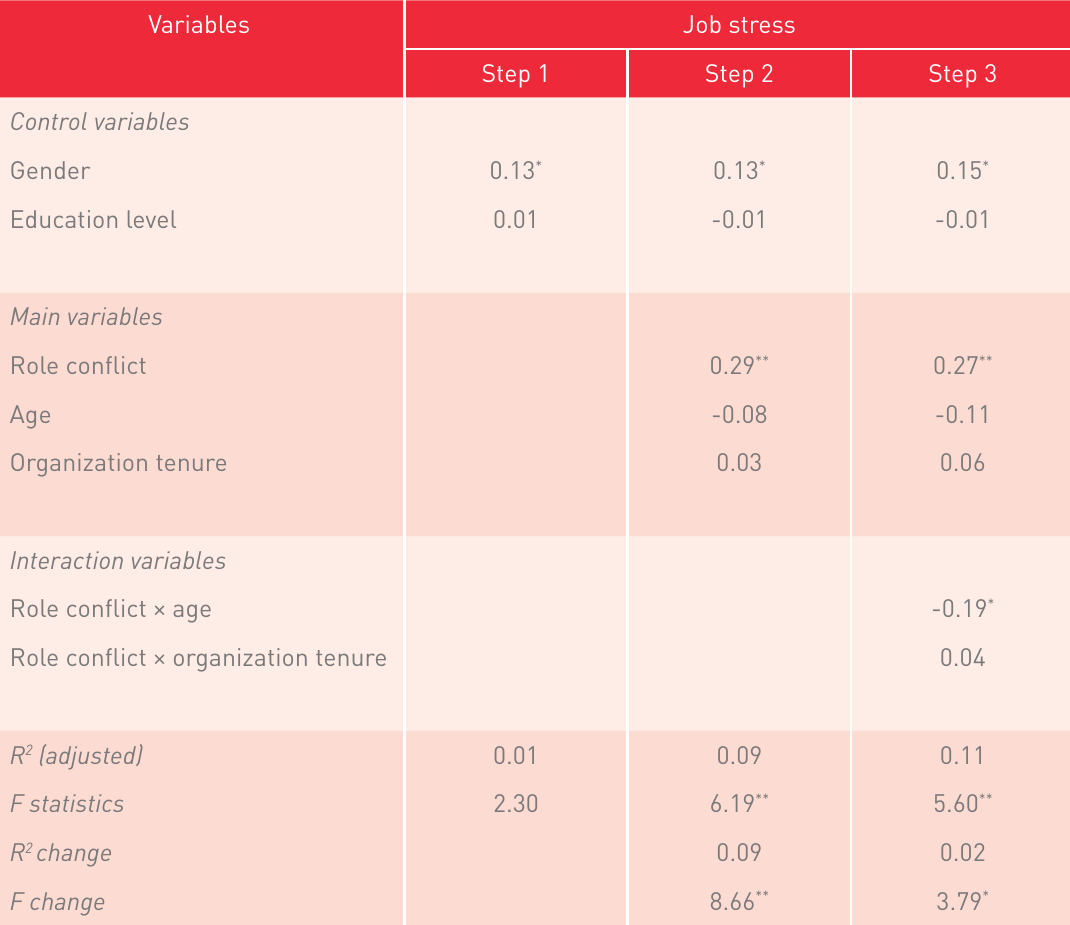
Hierarchical regression results on job